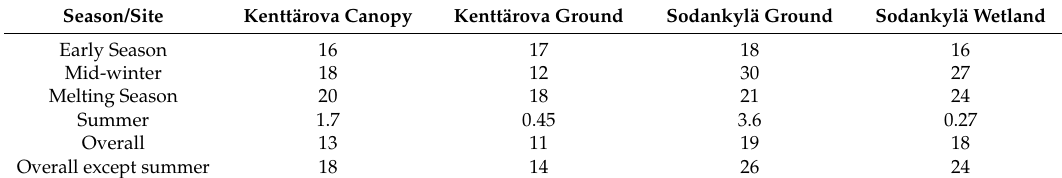
Table 4. RMSE for the fractional snow cover (FSC) from image processing for all seasons.